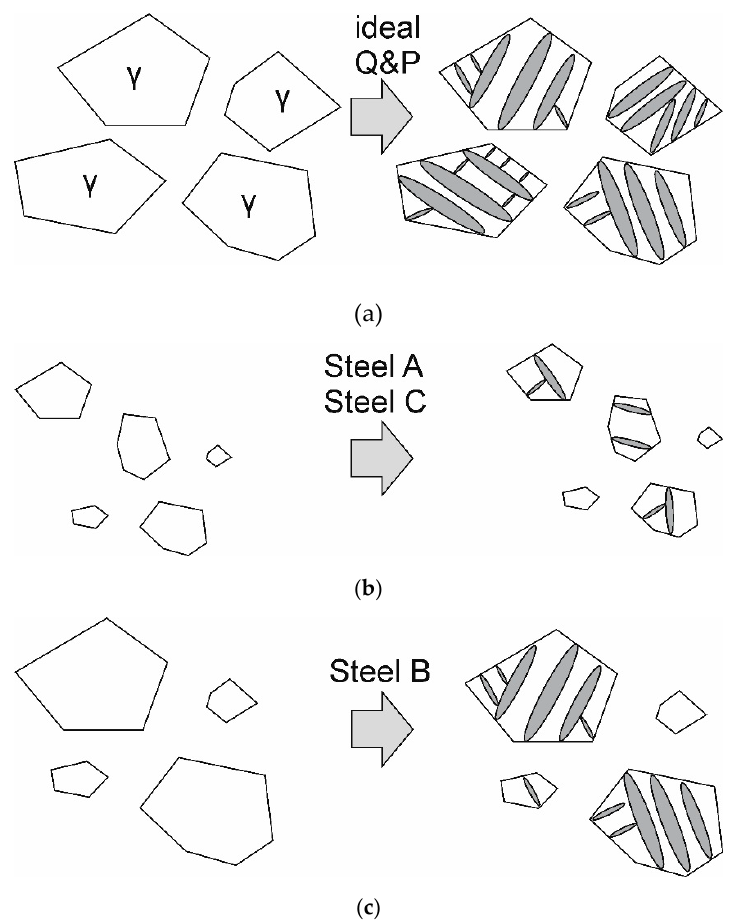
Figure 14. Austenite grains in a ferritic matrix partially transformed into martensite for ( a ) an ideal quenching and partitioning (Q&P) scenario, ( b ) the observed behavior of Steel A and Steel C and ( c ) the observed behavior of Steel B.